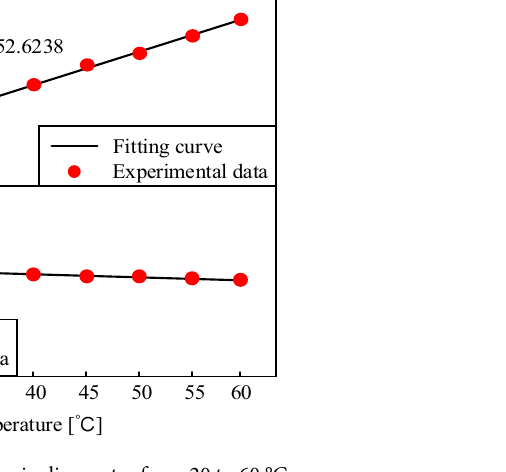
Figure 8. Temperature response of the inclinometer from 20 to 60